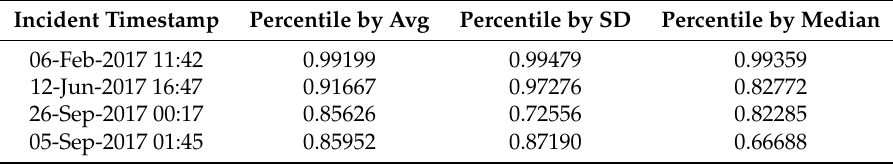
Table 3. Percentiles of incidents from the Phase1-Train data when sorted by sensor, day of week, and time of